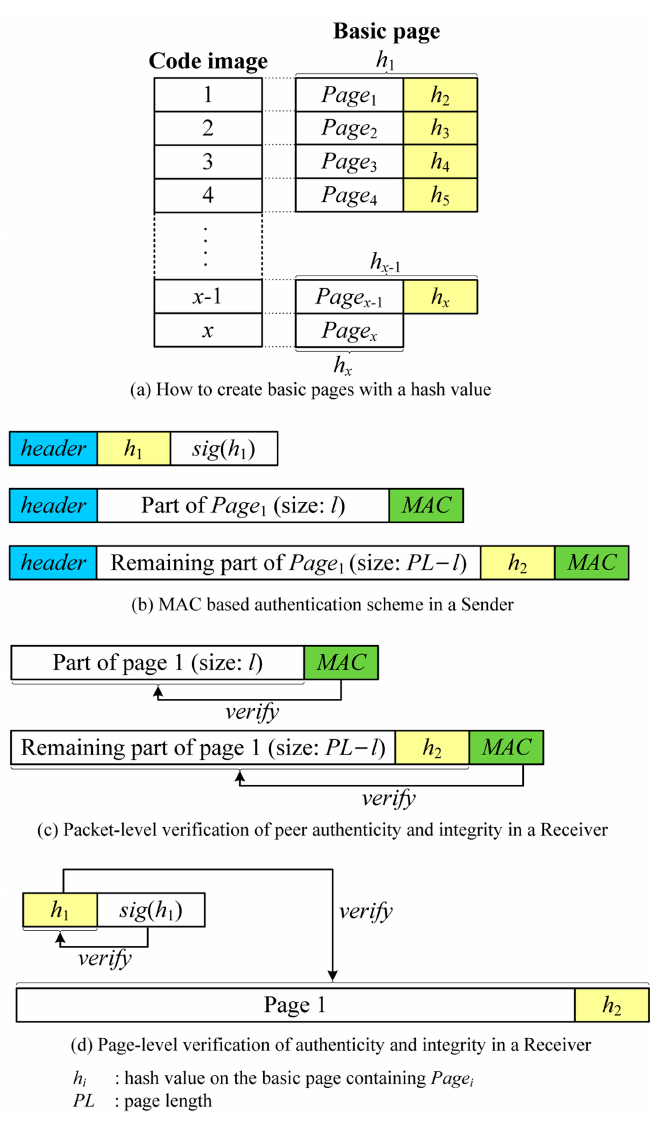
Figure 6. An example of MBSA.